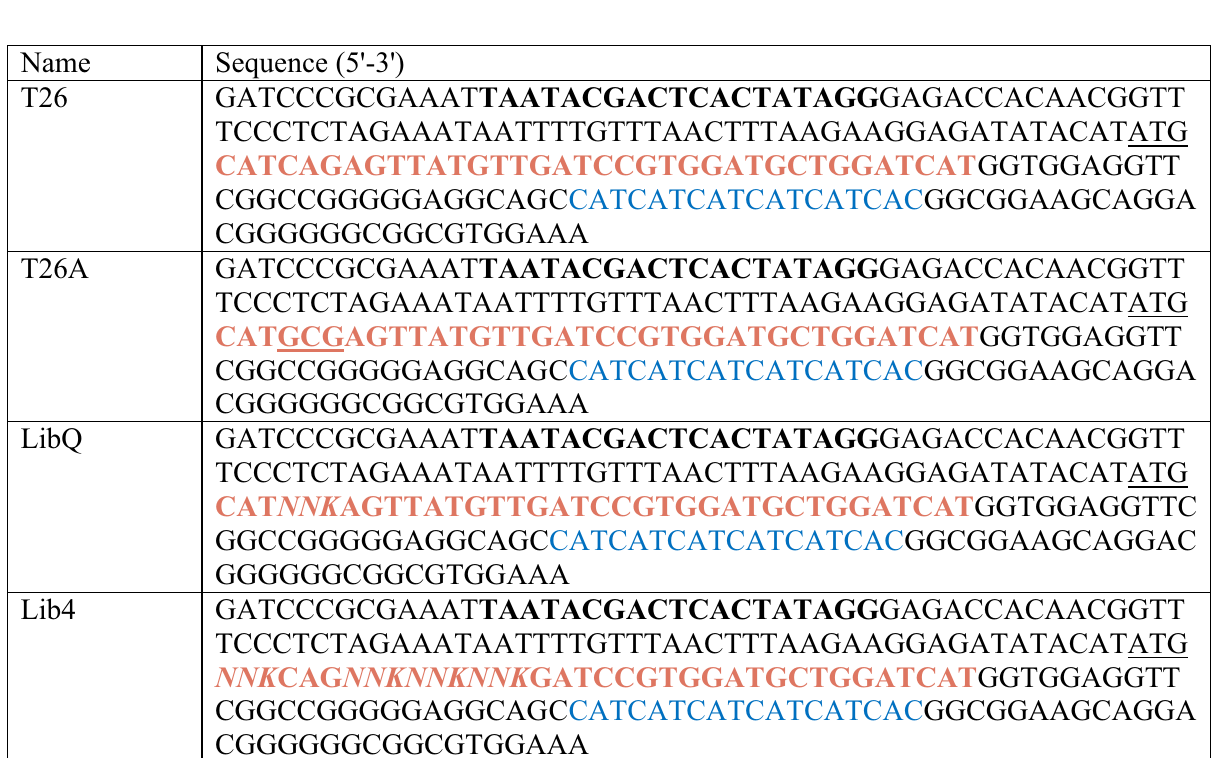
Table 2. DNA sequences of the cDNA display constructs used in this study. T7P sequence is bolded, peptide sequence is colored red, and 6xHis sequence blue. Randomized sites are